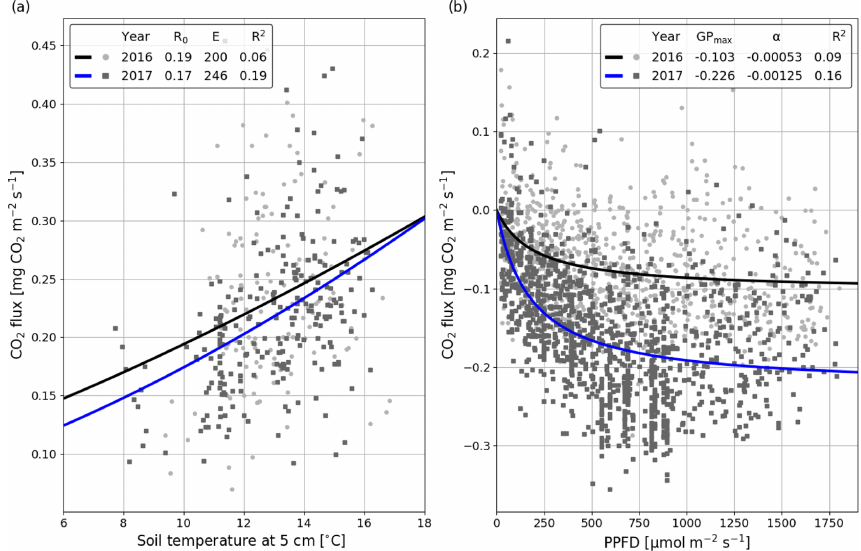
Figure 5. Temperature ( a ; Eq. A3) and light responses ( b ; Eq. A2) of 30min CO 2 fluxes for the summers of (JJA) 2016 (black) and 2017 (blue). The temperature response equation was fitted to the night-time data (PPFD < 20µmolm − 2 s − 1 ), and the light response equation was fitted to the daytime (PPFD > 20µmolm − 2 s − 1 )